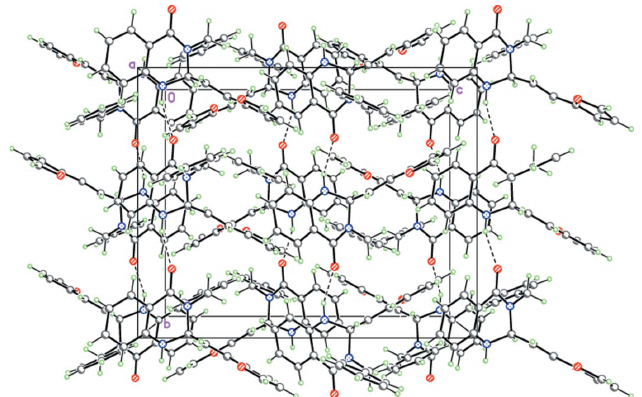
Figure 4 The crystal structure of (I), demonstrating the hydrogen-bonded helicoidal chains propagating in the [010] direction. Dashed lines indicate the intermolecular N—H (cid:3)(cid:3)(cid:3) O hydrogen bonds.